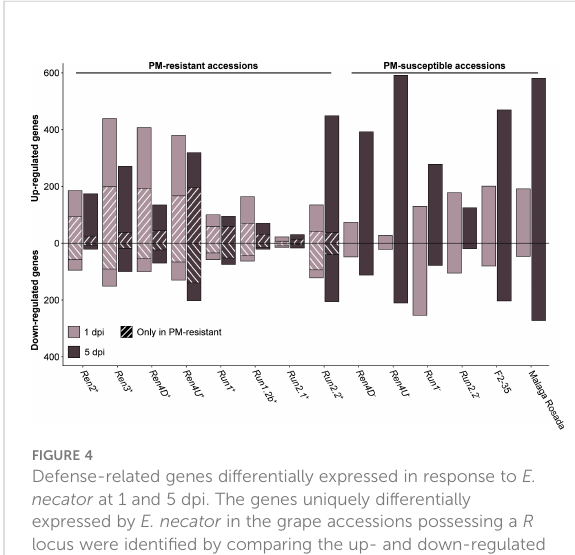
FIGURE 4 Defense-related genes differentially expressed in response to E. necator at 1 and 5 dpi. The genes uniquely differentially expressed by E. necator in the grape accessions possessing a R locus were identi fi ed by comparing the up- and down-regulated genes in PM-resistant leaves with the ones detected in PM- susceptible vines at each time